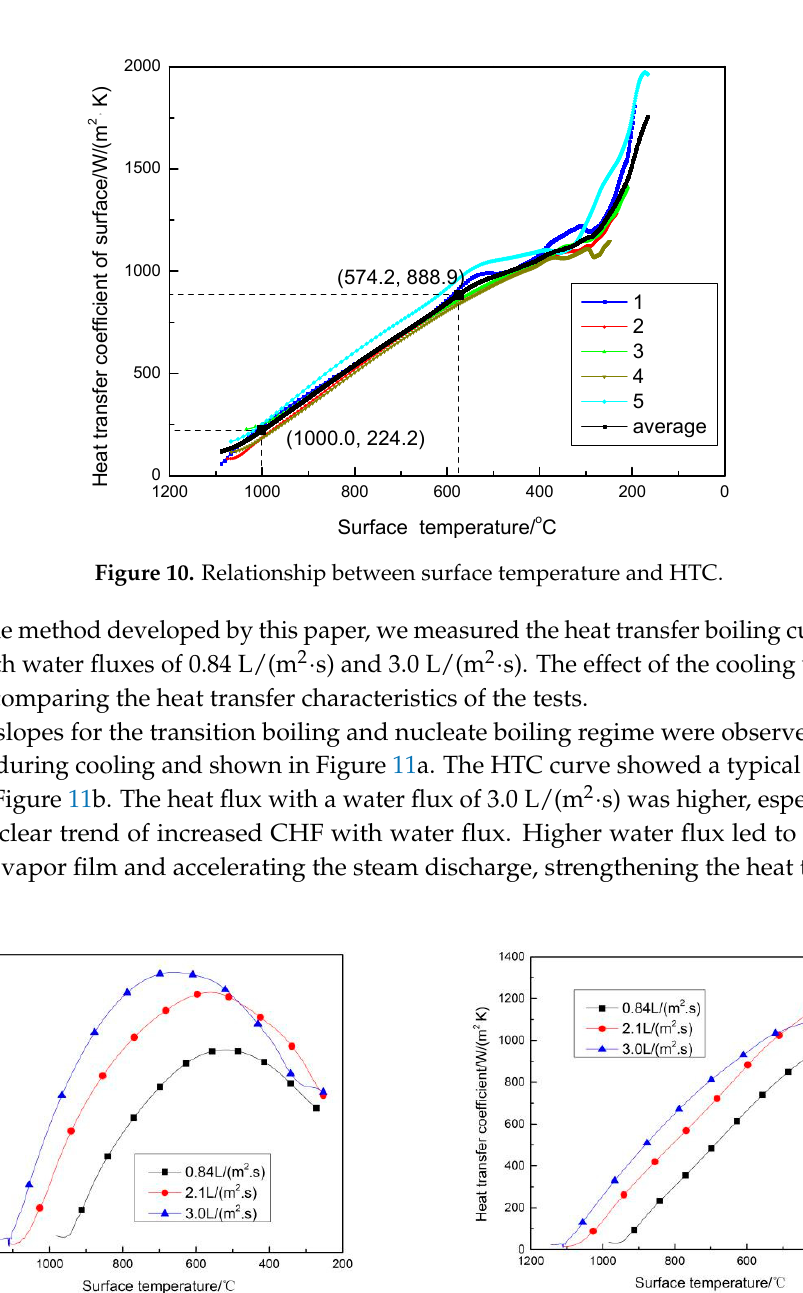
Figure 11. Heat characteristics with different water flux for ( a ) heat flux; ( b ) HTC.